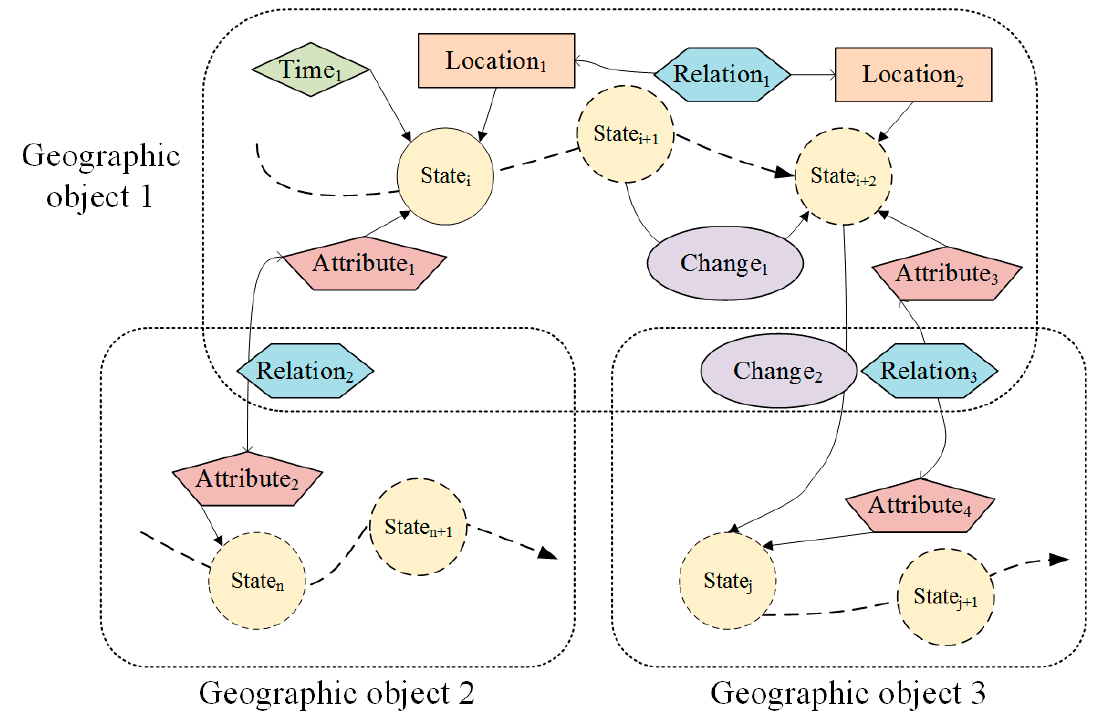
Figure 3. A conceptualized model of GeoKG based on the six basic elements.